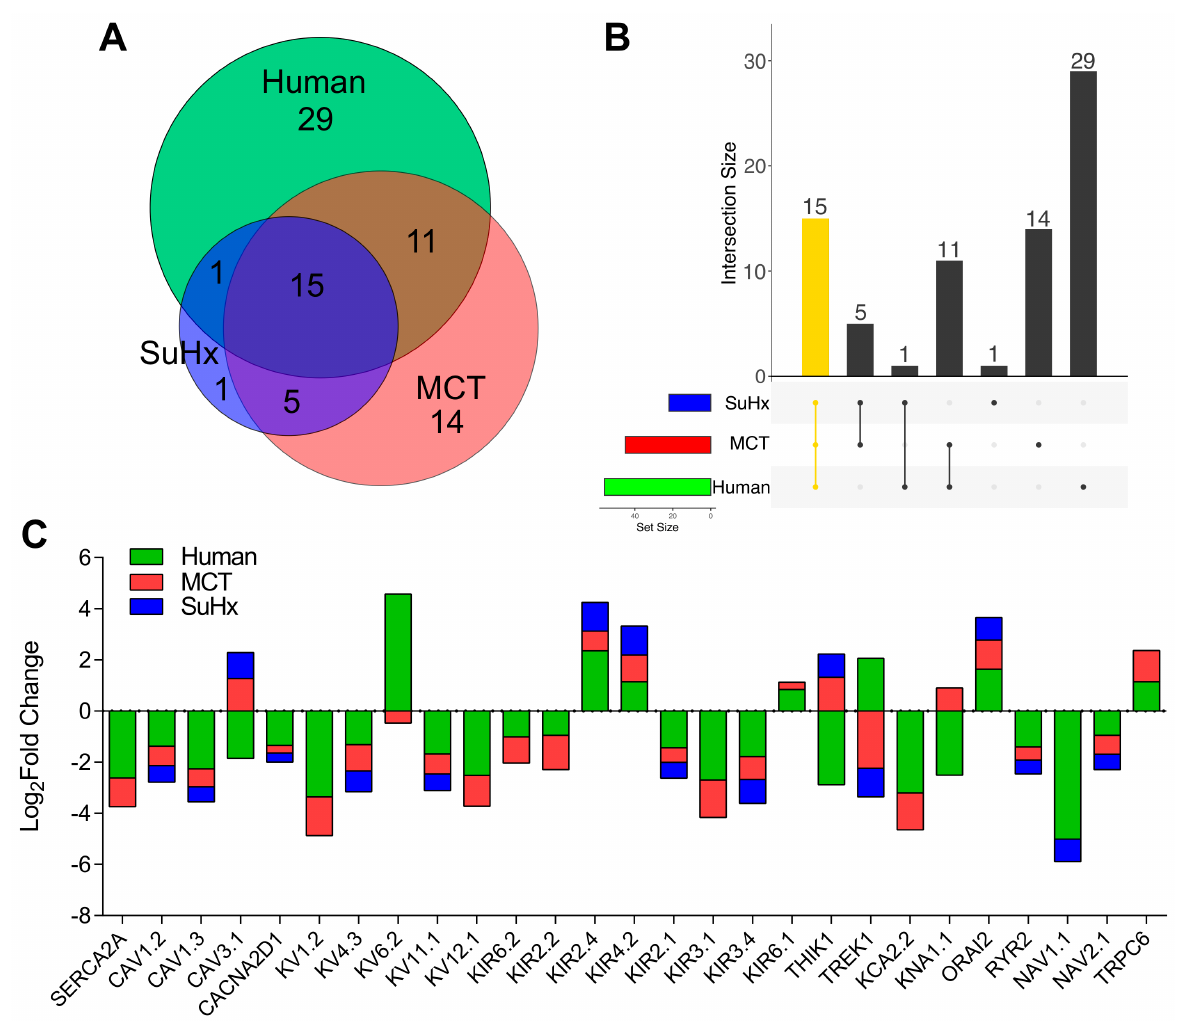
Figure 2. Channel gene expression profile analysis of MCT, SuHx, and PAH patient with decom- pensated RV. ( A ) Venn diagram of overlapping dysregulated DEGs from MCT, SuHx, and Human (RV-D versus RV-CTRL). ( B ) UpSet plot of the intersection between MCT, SuHx, and Human. Yellow represents overlap of SuHx, MCT, and Human. ( C ) Stacked graph showing Log2 fold change of statistically significant DEGs present in MCT (red) and/or SuHx (blue) with human (green).